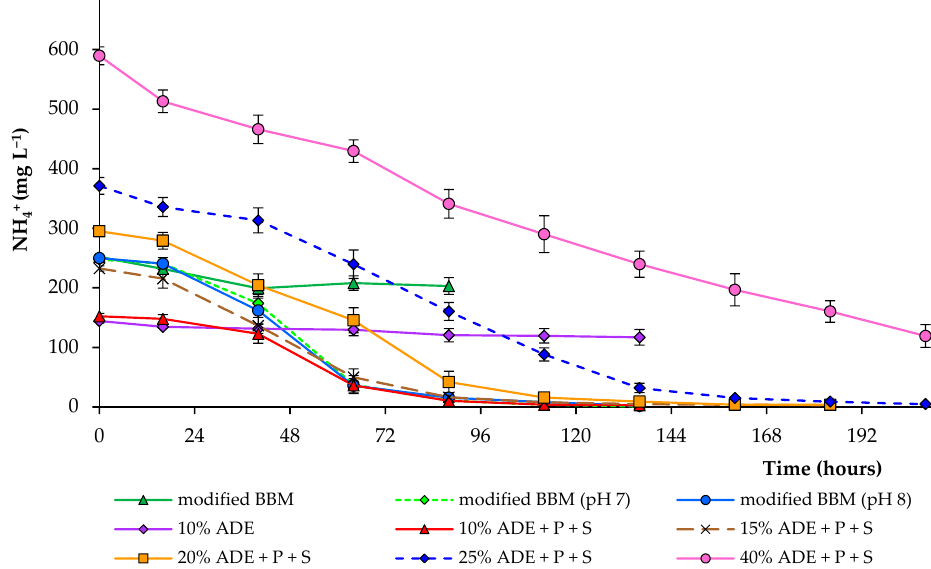
Figure 4. Ammonium concentrations in modified BBM and diluted ADE during the growth of C. sorokiniana AM-02.